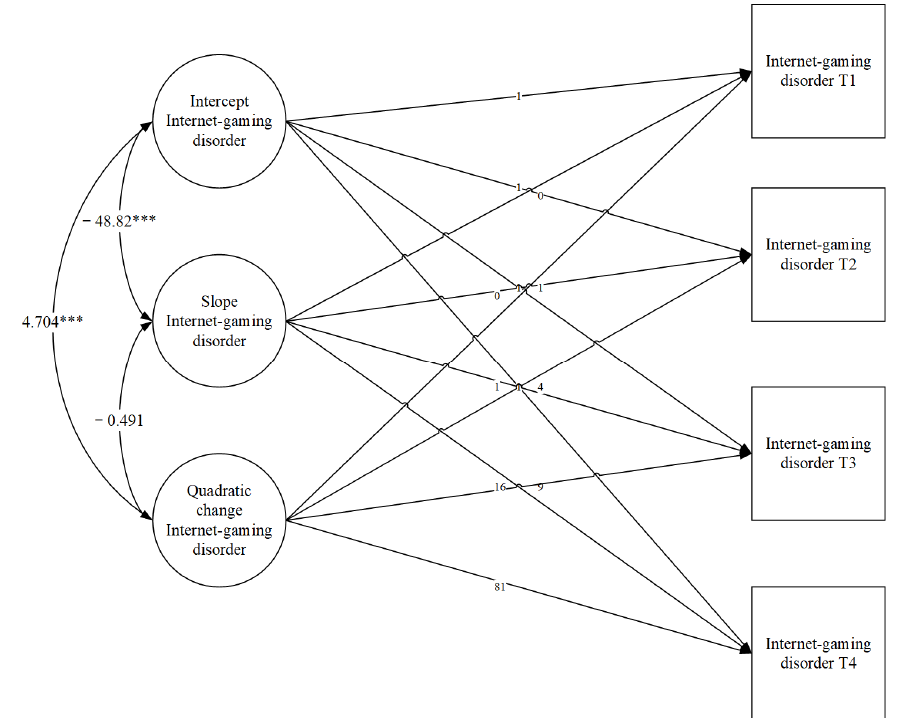
Figure 1. Unconditional quadratic LGMs. *** p < 0.001.